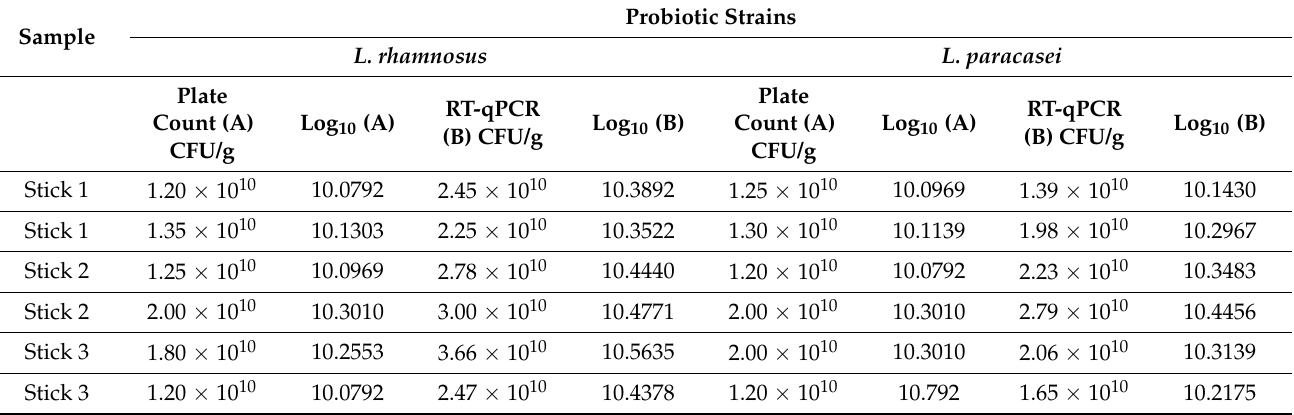
Table 8. Count results by RT-qPCR of food supplement 2 expressed as Log10 for Lactobacillus rhamnosus and Lactobacillus paracasei